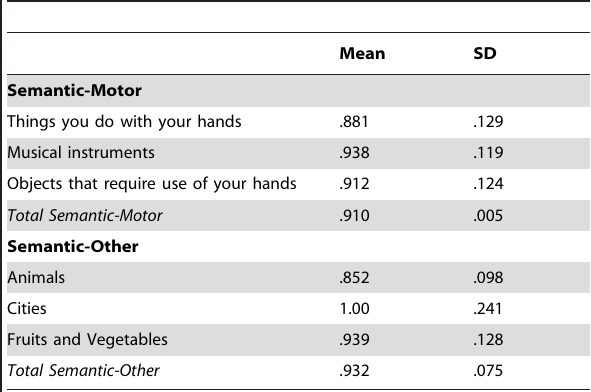
Table 4. Word Duration Means by Semantic Condition (Exp